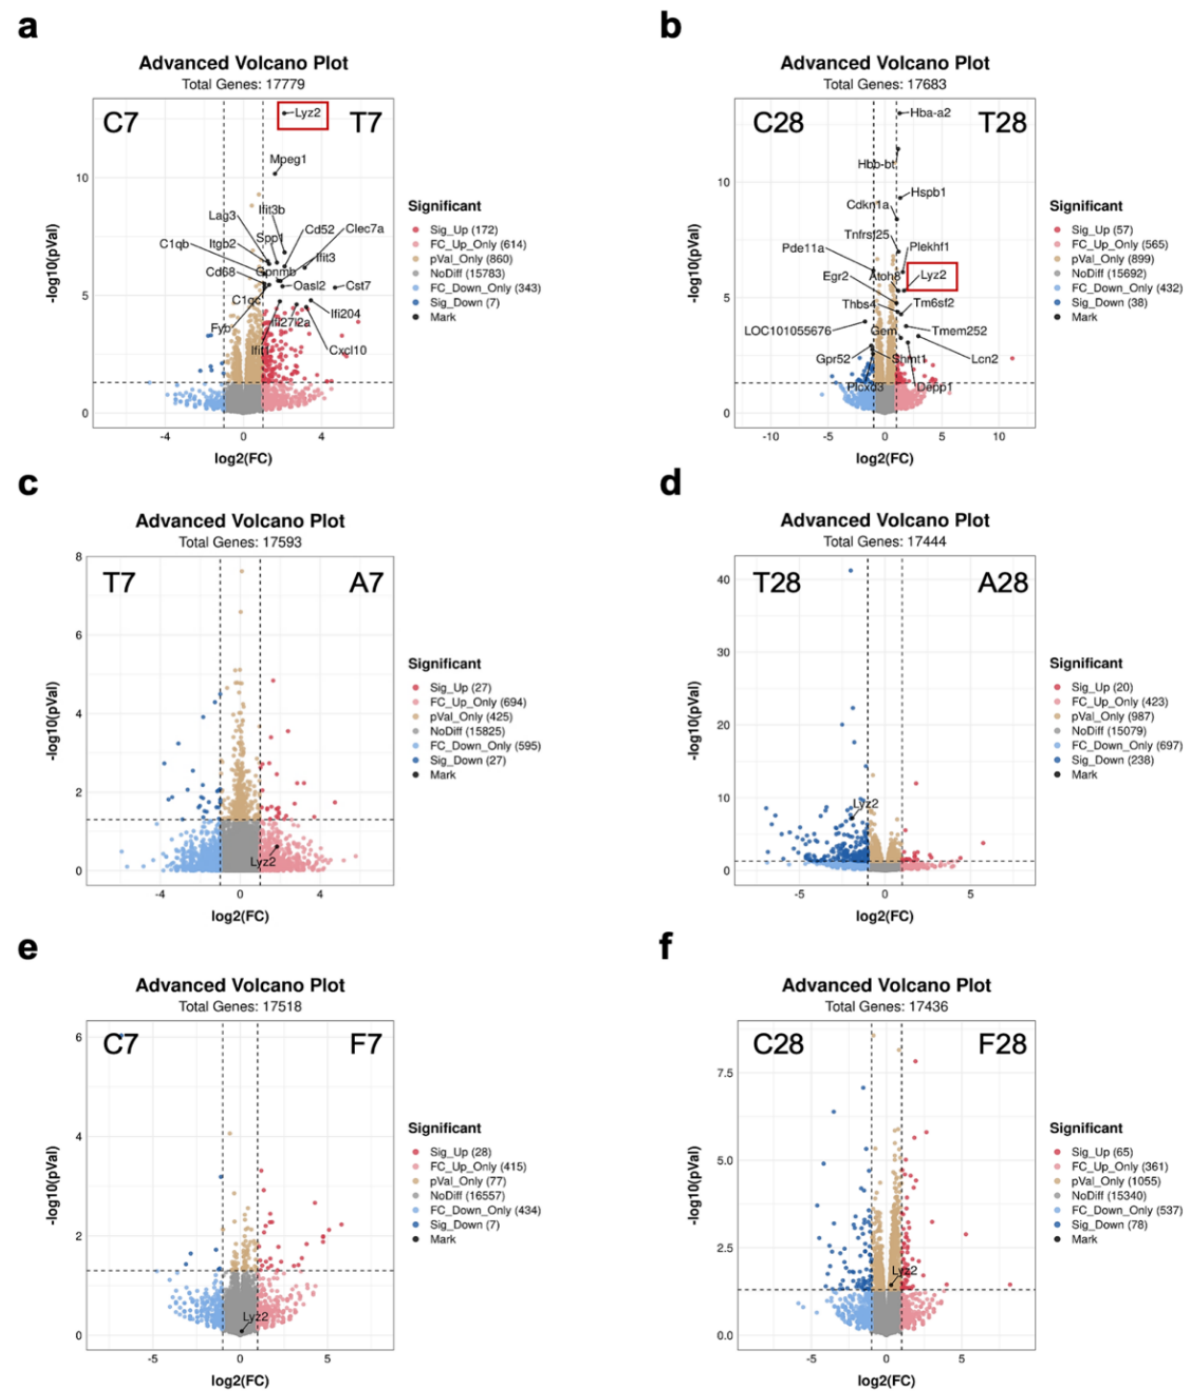
Figure 4. Gut microbiota-dependent persistent upregulation of Lyz2. Advanced volcano plot analysis of gene expression levels of the hippocampus: between control mice and TBI mice at 7 days ( a ) and 28 days ( b ) post-TBI; between TBI mice and antibiotic-treated TBI mice at 7 days ( c ) 28 days ( d ) post-TBI; between control mice and TBI-colonized mice at 7 days ( e ) and 28 days ( f ) post-TBI ( n = 3 per group). TBI, traumatic brain injury; Lyz2, lysozyme 2. 3.3. Tryptophan Metabolic Phenotype Was Differently Reshaped at 7 Days and 28 Days